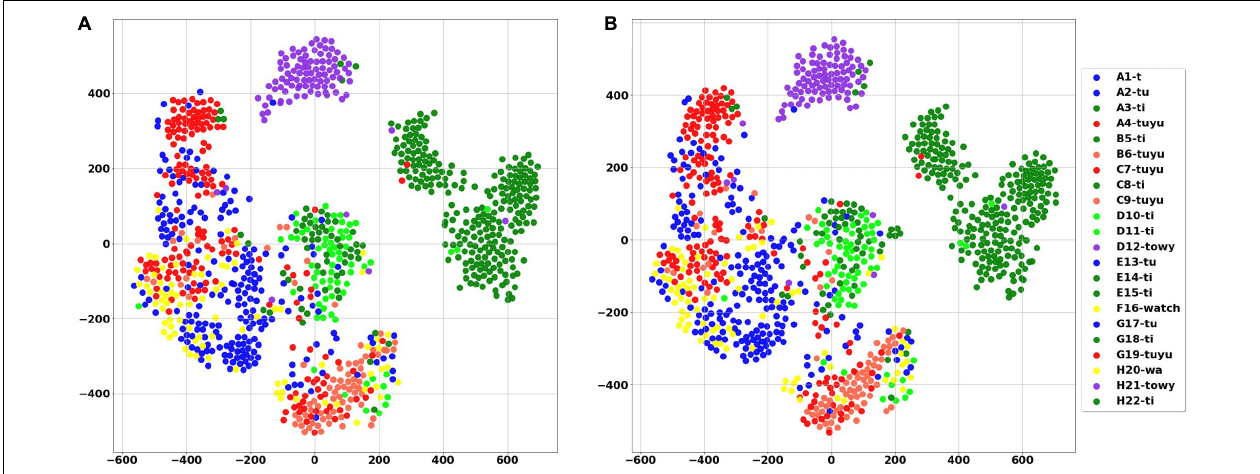
FIGURE 10 | Visualization of syllables using tSNE. Each syllable is represented by a single point. (A) The analysis includes all parameters. (B) The analysis includes only 4 Legendre coefficients. In both figures same syllables appears in different words. For example, the purple dots that represent the syllable " towy ," were excerpted from two different words (denoted by the letters D and H) and are clustered together. Similarly, the syllable " ti " (dark green), derived from six different words, resides in the same region both in PCA and tSNE analyses.